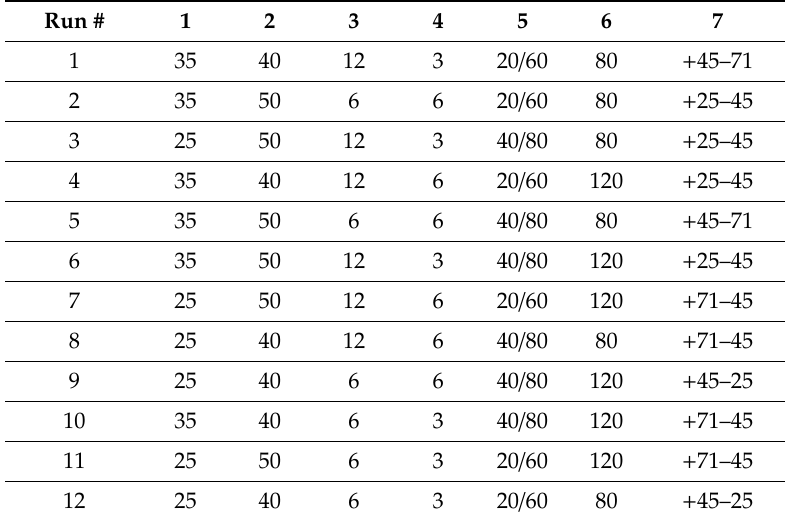
Table 1. Plasma-spray parameter matrix chart according to a 12-run Plackett-Burman screening design [24] with 7 factors [21].